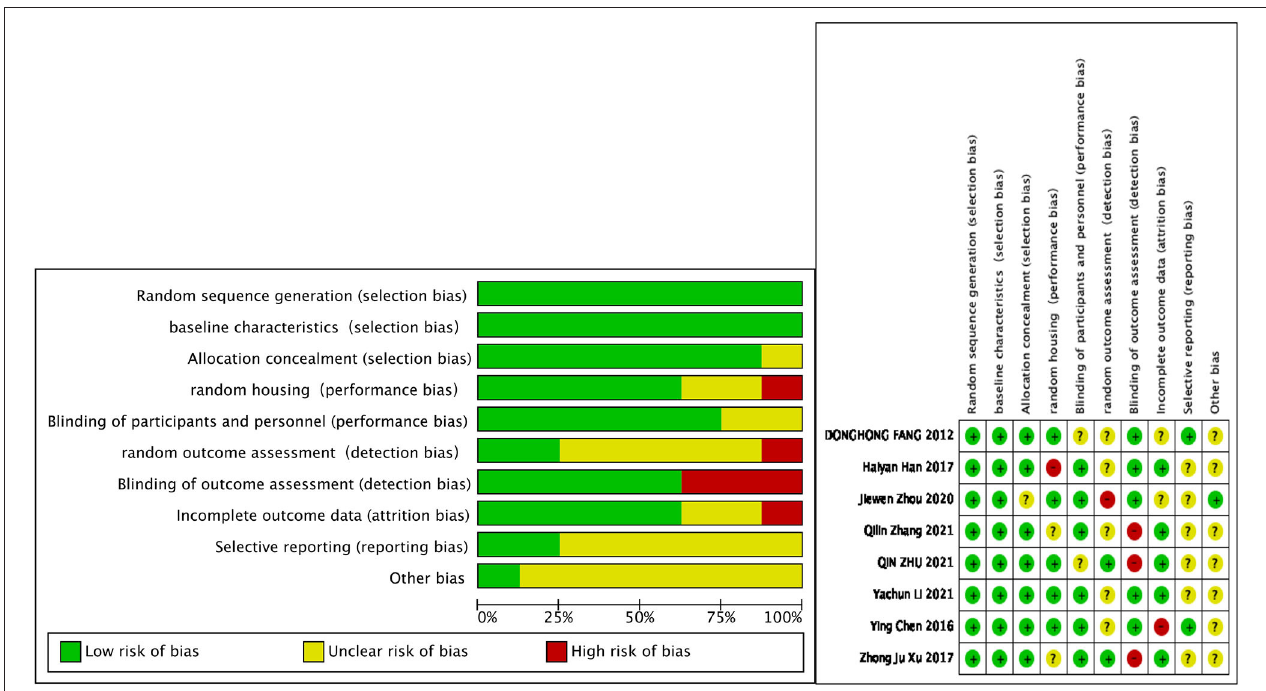
FIGURE 3 | The risk of bias summary of review authors